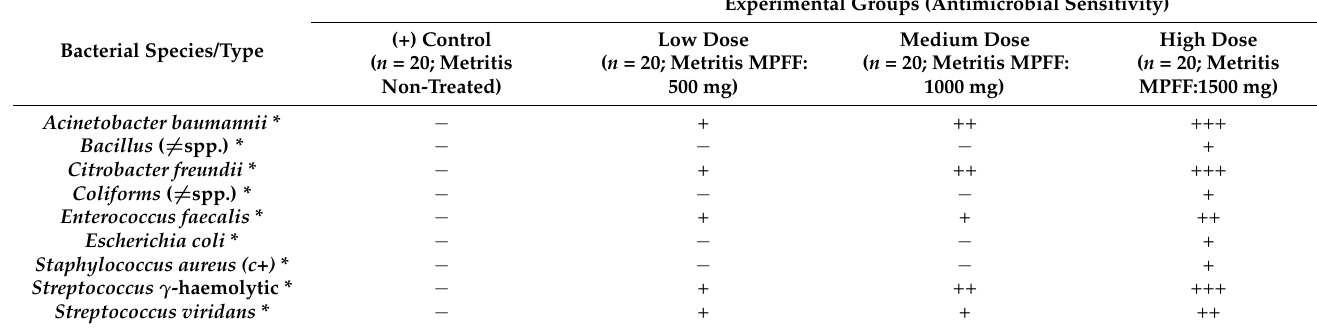
Table 7. Micronised Purified Flavonoid Fraction (MPFF; low, medium and high concentrations) sensitivity patterns of the pathogenic isolated bacteria obtained in in vitro cultures derived from intrauterine swab samples (Cytobrush) in metritis-diagnosed dairy cows naturally infected by E. coli during the early postpartum